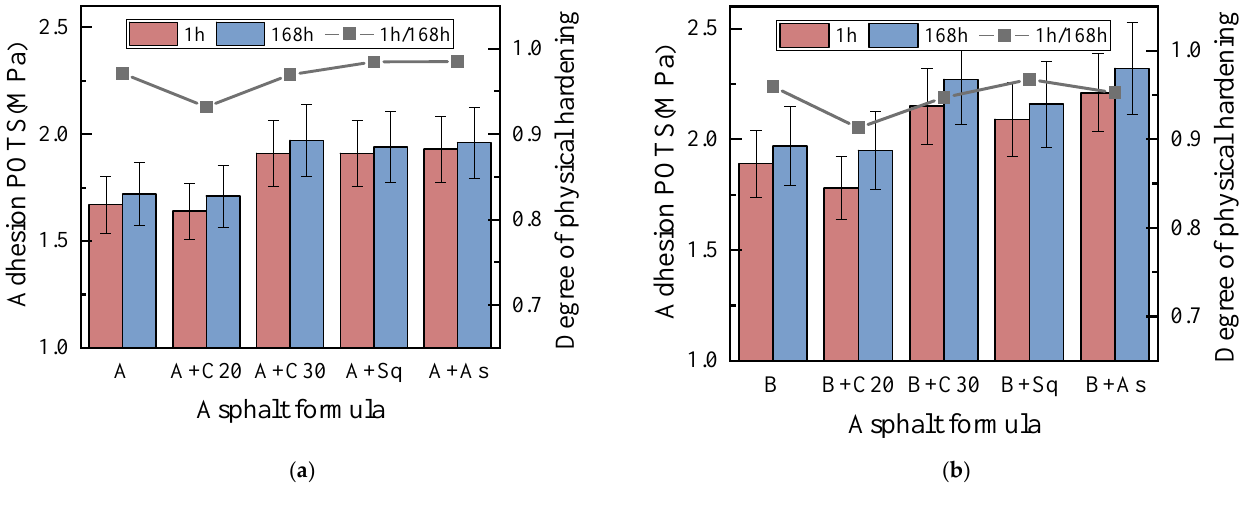
Figure 7. Adhesion POTS in wet conditions. ( a ) Asphalt A. ( b ) Asphalt B. In this paper, according to AASHTO T283 [36], the ratio of mechanical strength after moisture-induced damage to that before moisture-induced damage is taken as the moisture sensitivity index of the asphalt binder. A moisture sensitivity index of the BBS test, pull-off tensile strength ratio (POTS Ratio) is put forward. The larger the value, the smaller the moisture sensitivity of asphalt. On the contrary, the larger it is, as shown in Equation (5). POTS Ratio = Adhesion POTS/Cohesion POTS (5) In Equation (5), Adhesion POTS represented POTS after moisture-induced damage, Cohesion POTS represented POTS before moisture-induced